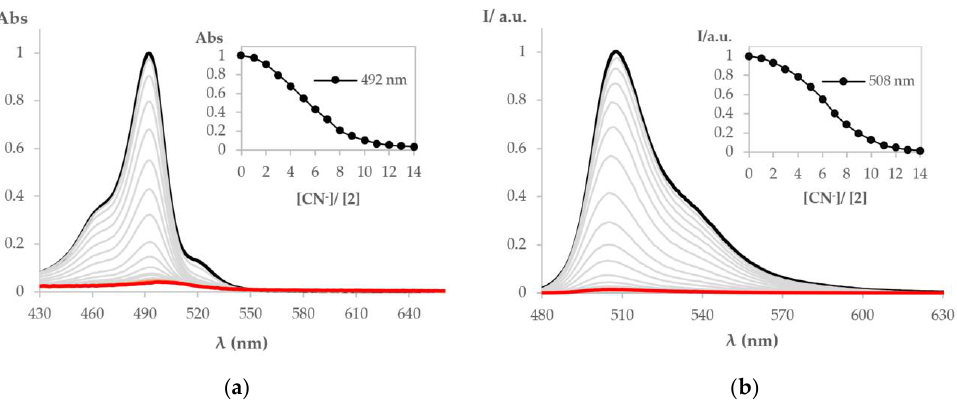
Figure 4. ( a ) Spectrophotometric and ( b ) spectrofluorimetric titration spectra of BODIPY derivative 2 upon addition of increasing quantities of CN − (0 eq.—black line, to 14 eq.—red line) in acetonitrile. Inset: normalized absorbance and emission intensities at 492 nm and 508 nm, respectively, as a function of [CN − ] / [ 2 ].